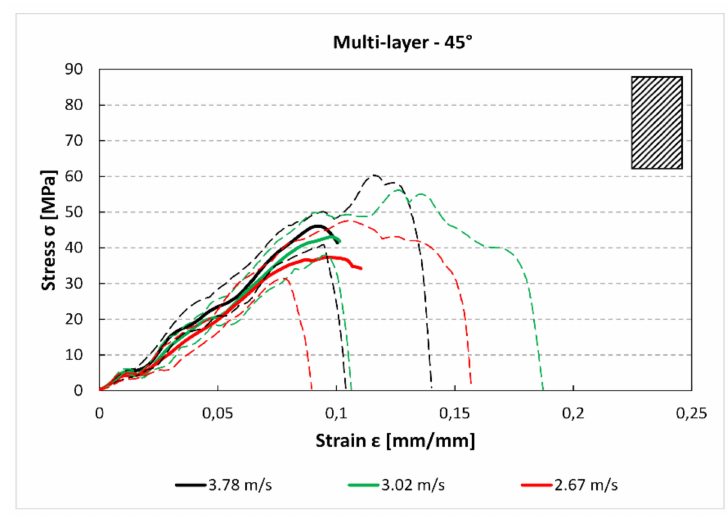
Figure 13. Multilayer stress–strain curves for 45 ◦ specimens and for each impact speed.